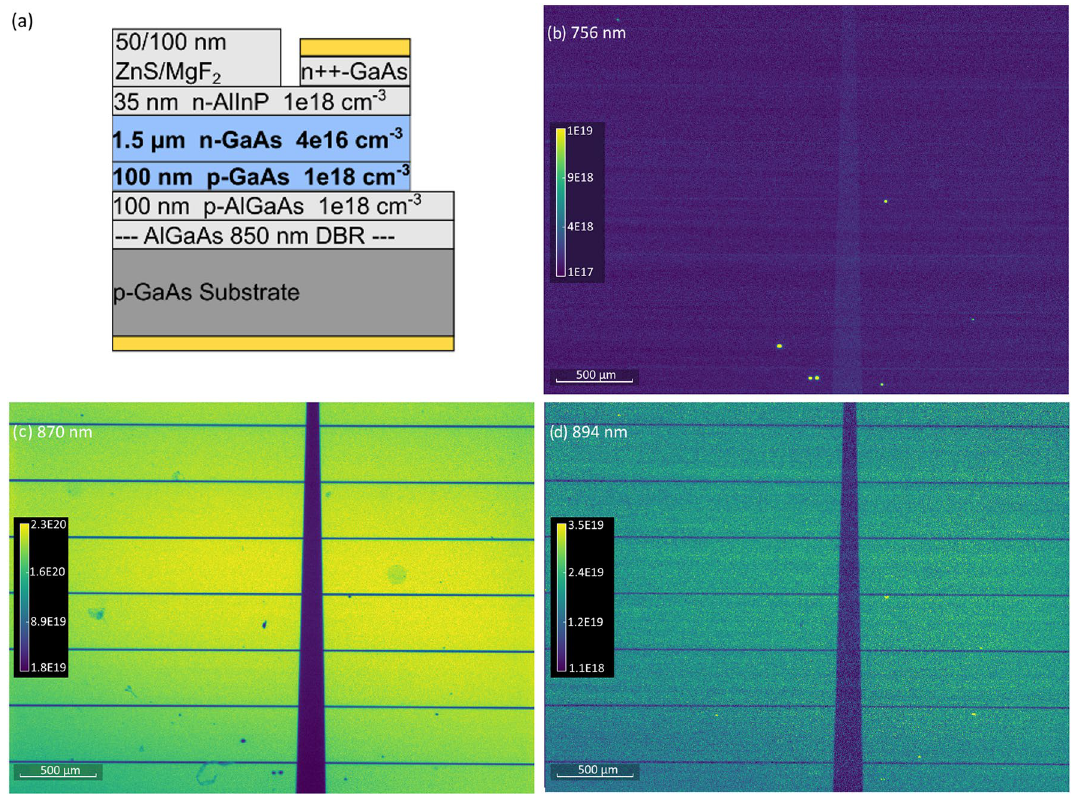
Figure 1. ( a ) Layer structure of the GaAs devices. ( a – d ) Absolute PL spectral photon flux maps in photons/ (m 2 s eV) at 300 K and several wavelengths corresponding to the peak emission wavelength of the ( b ) DBR layer, ( c ) BB transition, and ( d ) FB